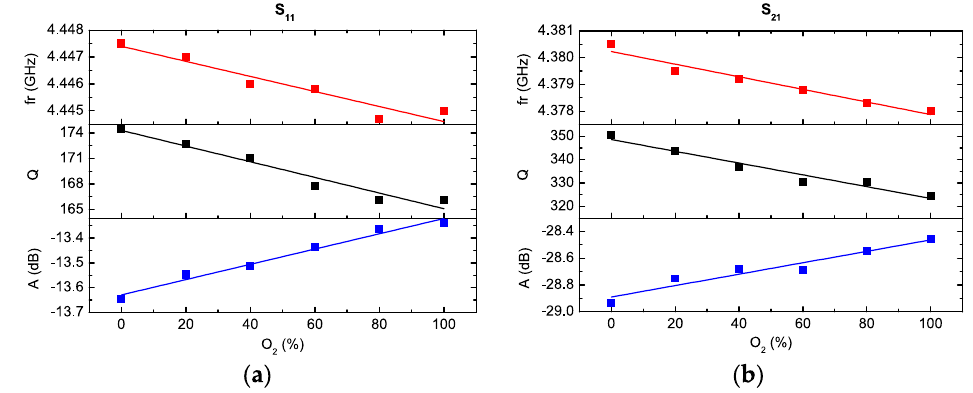
Figure 6. Behavior of the resonant frequency, quality factor, and amplitude at the resonance for the studied sensor by considering six different O 2 concentrations. The plotted trends refer to the dips observed at about 4.4 GHz in ( a ) | S 11 | and in ( b ) | S 21 | ( b ). A linear interpolation has been carried out on the acquired points with a R 2 higher than